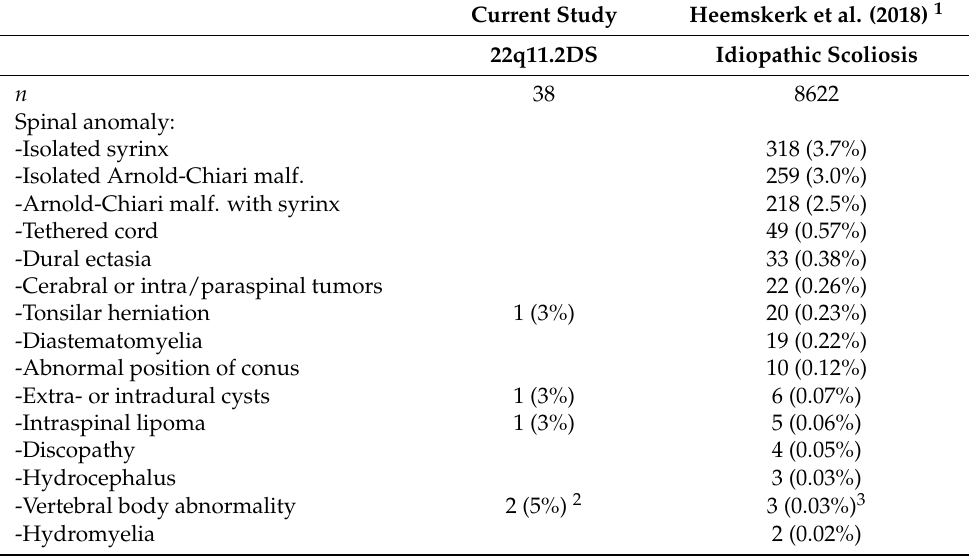
Table 2. Intraspinal anomalies in 38 patients with 22q11.22 deletion syndrome and scoliosis compared to idiopathic scoliosis in the general population, as described by Heemskerk et al.